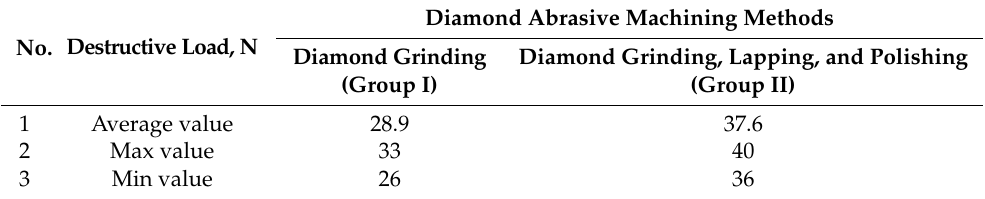
Table 4. Loads on the indenter corresponding to the chipping of the SiAlON ceramic inserts’ cutting edges after various diamond abrasive machining methods (measuring error of ± 1.5